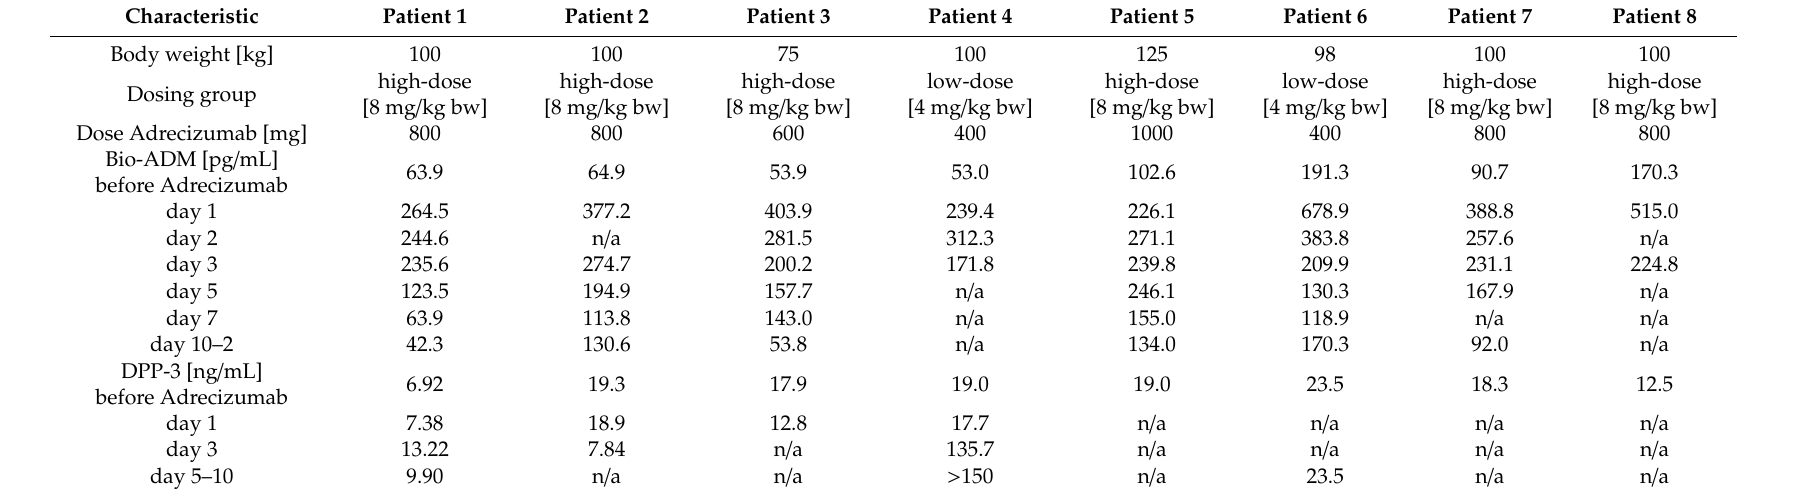
Table 2. Dose of Adrecizumab administered and course of therapy-guiding biomarkers bio-ADM and DPP-3.